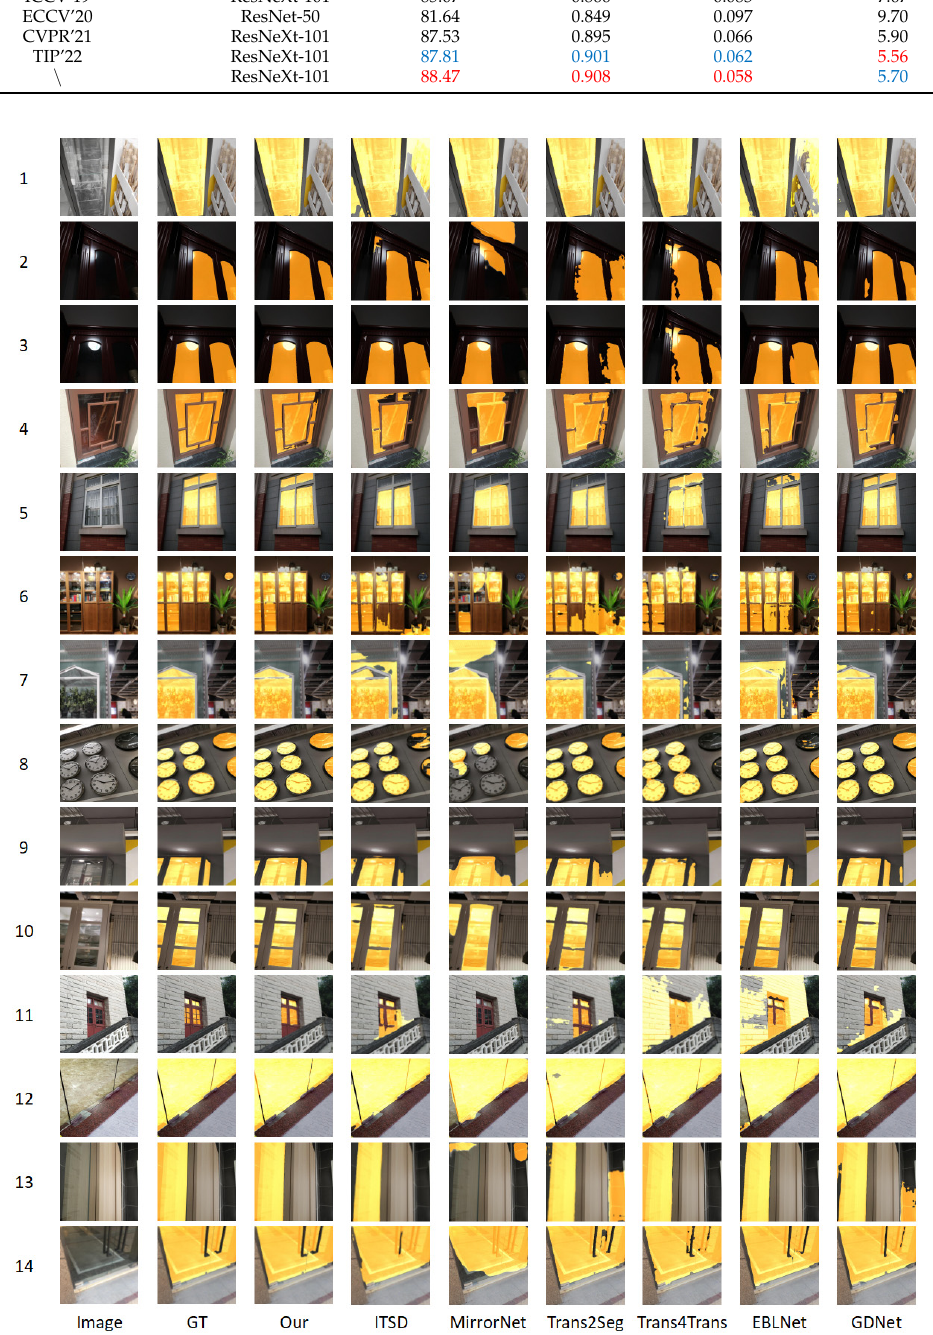
Figure 9. Results of visual comparison between our TGSNet and six other methods. Since the GDD dataset does not contain test data for lighting conditions, we took photos of glass doors at the same location during the day and night as a small light con- dition experiment. Figure 10 shows that our method works well for glass segmentation both in the daytime and nighttime, where we made the ground truth manually.